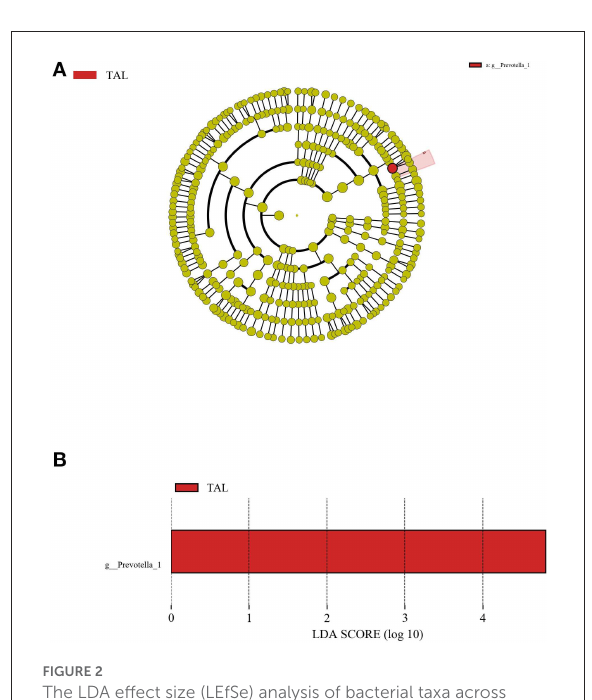
FIGURE2 The LDA effect size (LEfSe) analysis of bacterial taxa across treatments. (A) Cladogram displays significantly enriched bacterial taxa (from the phylum to the species level). Red: taxa abundant in the TAL treatment. (B) Bar chart displays LDA scores across treatments. The LDA scores represented the difference in relative abundance with exponent fold change of 10 across treatments. Significant differences are defined as P < 0.05 and LDA score >